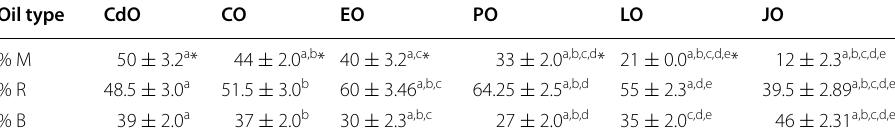
*Various super‑indices, i.e. a, b, c, d and e indicate statistical differences in repellence between the Eos (p<0.05 ANOVA) and Tukey Kramer post hoc analysis. a Statistical difference of CdO with other Eos, b Statistical difference of CO with other Eos, c Statistical difference of EO with other Eos, d Statistical difference of PO with other Eos, and e Statistical difference of LO with other Eos